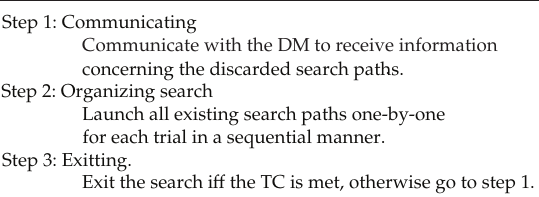
Figure 6: The SM procedures.